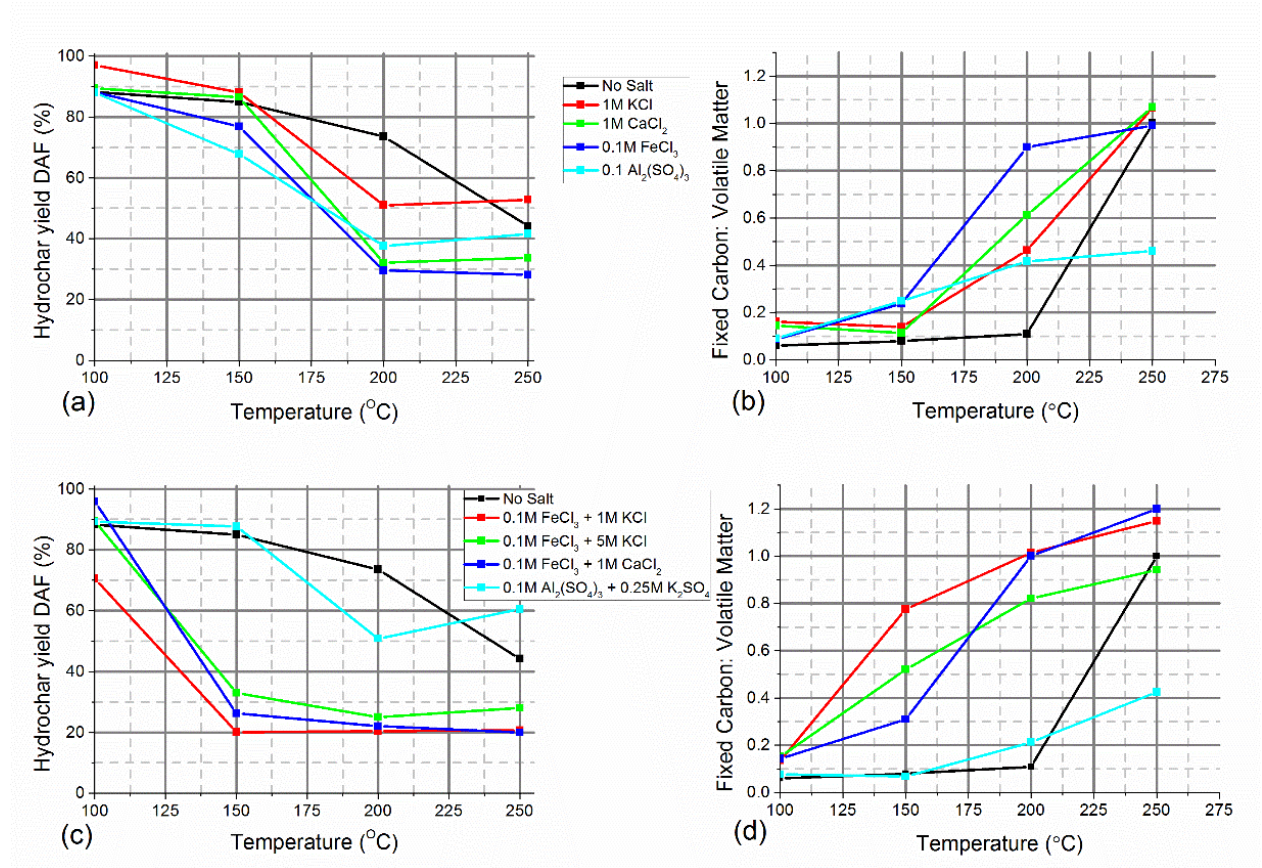
Figure 6. Hydrochar mass yields on a dry ash-free basis (DAF) and the ratio of fixed carbon to volatile matter of the produced hydrochar. ( a , b ) hydrochars produced in the presence of a single salt, and ( c , d ) produced with a combination of two salts.